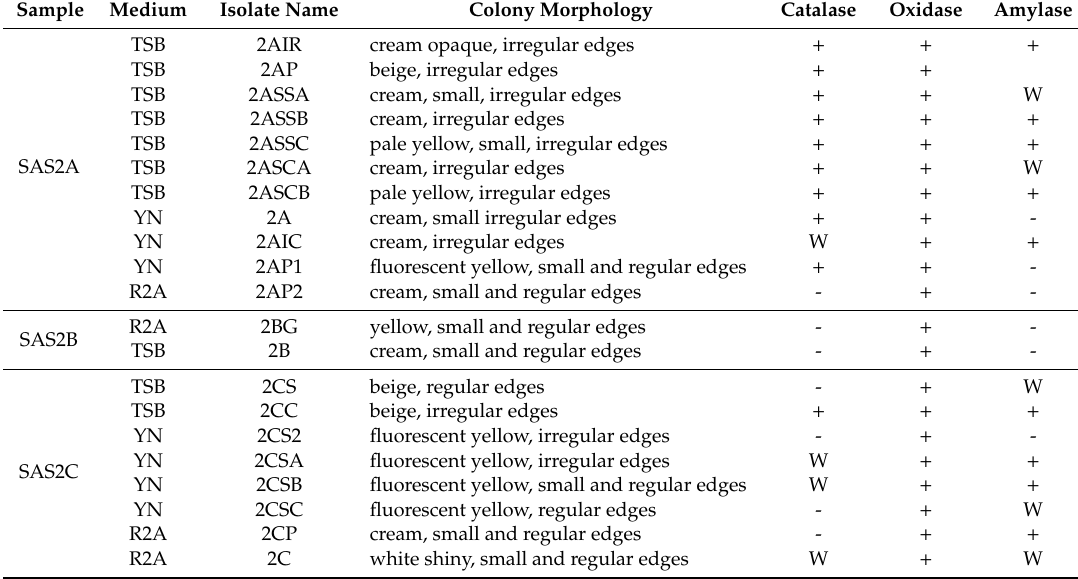
Table 1. Main properties of strains isolated from SAS2A, SAS2B, and SAS2C sampled sites. Sample